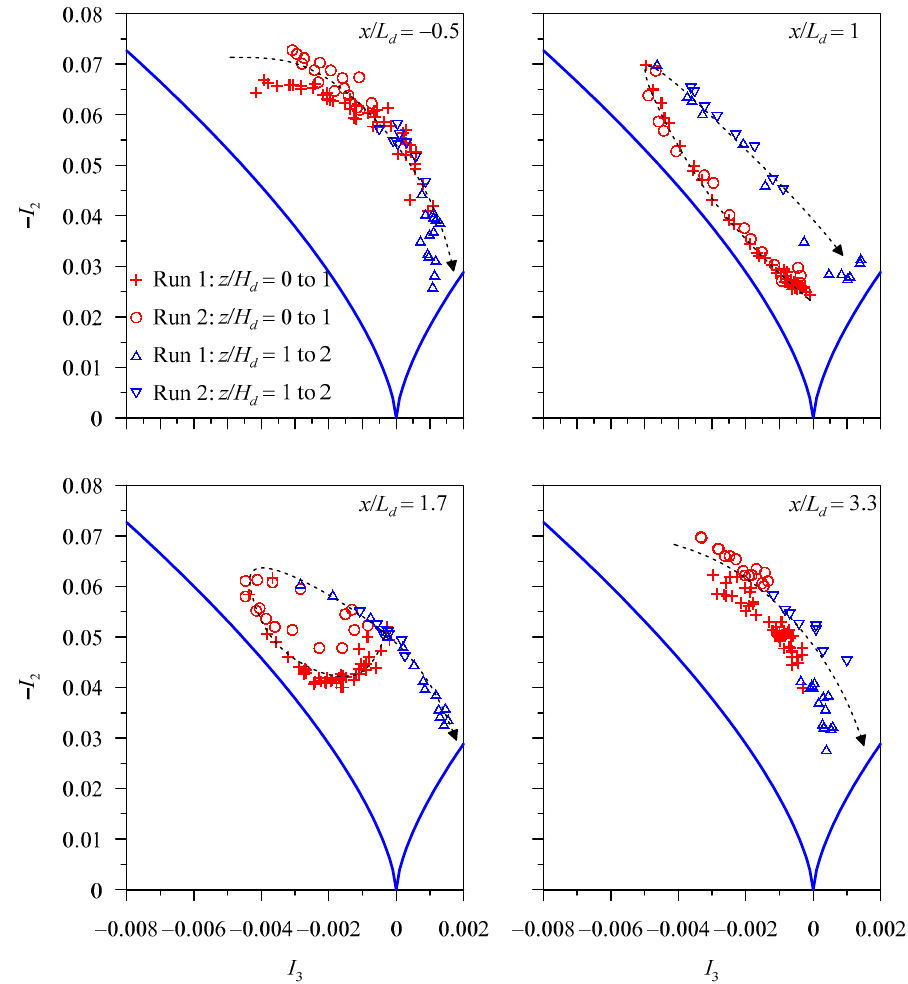
Figure 15. AIMs at various relative streamwise distances x / L d in Runs 1 and 2.